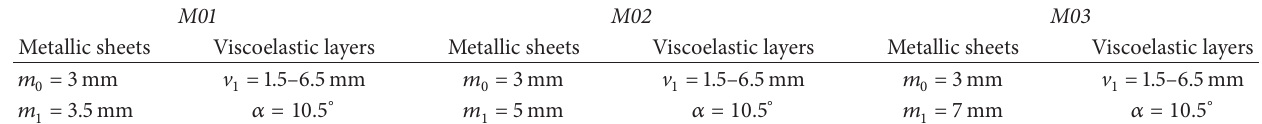
Table 6: Geometric parameters of the three monolayer damper designs.